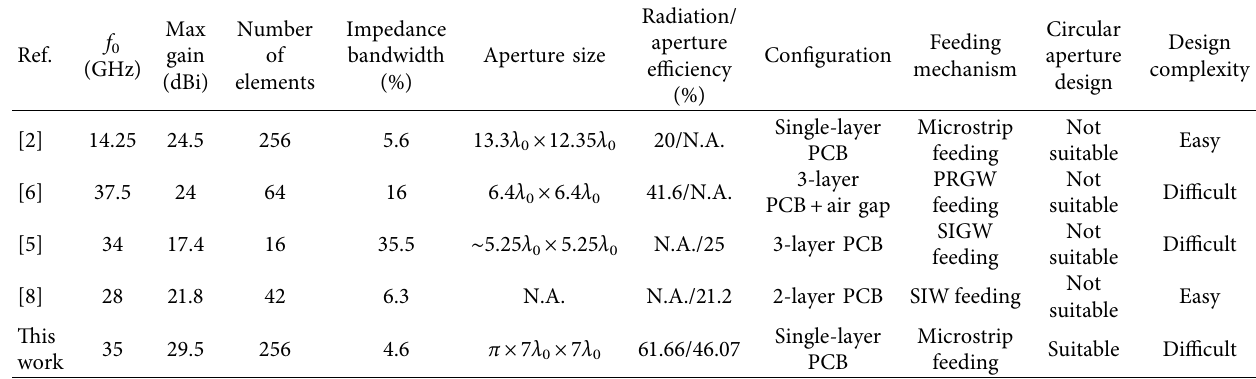
Table 2: Comparison with other reported planar array antennas.